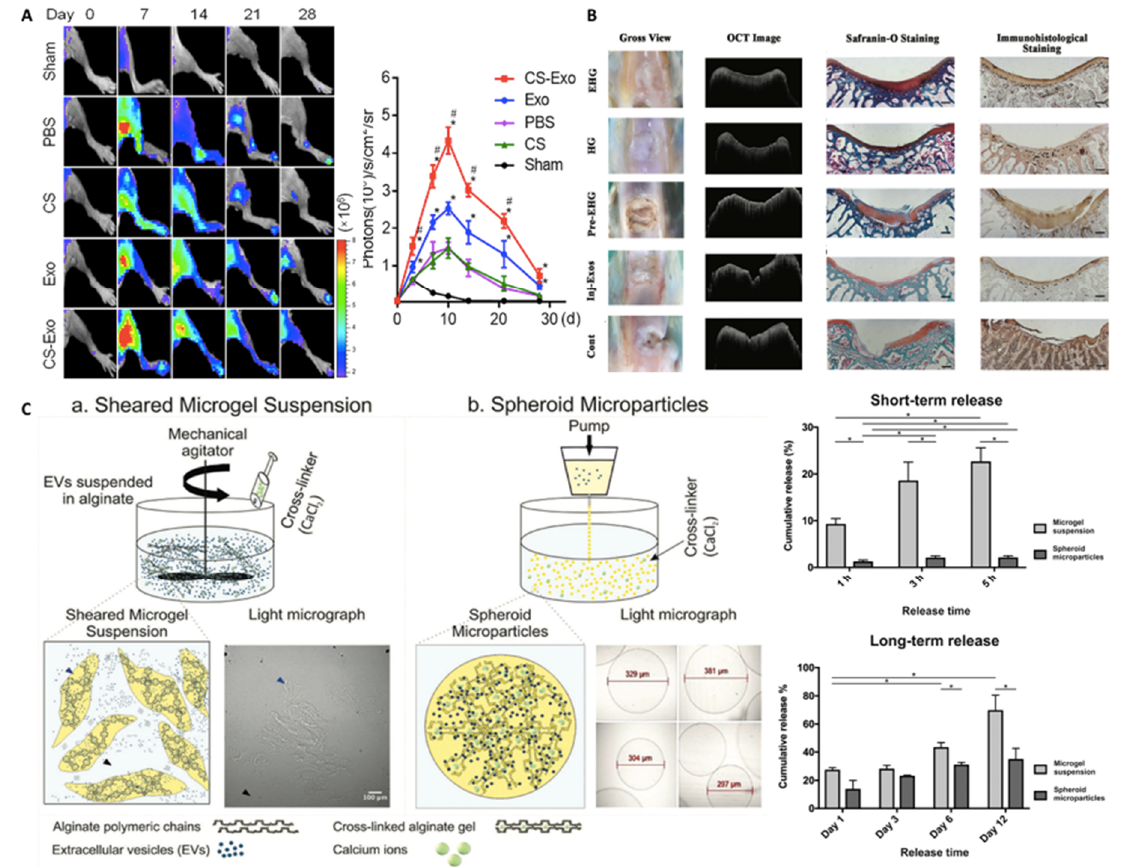
Figure 8. Encapsulation of EVs within different hydrogel systems. ( A ) MSC-derived exosomes with an injectable hydrogel for hindlimb ischemia treatment. EVs encapsulated within chitosan hydrogel demonstrated enhanced retention at the site of injury when compared to local delivery with EVs alone. Adapted from [134], with permission from American Chemical Society, 2018. *, p < 0.05 compared to PBS; #, p < 0.05 compared to Exo. ( B ) Superior reparation of articular full-thickness rabbit defects treated with in situ forming EV-functionalised hydrogel (EHG) when compared to hydrogel alone (HG), pre-formed EV-hydrogel (Pre-EHG), EV delivery alone (Inj-Exos). Adapted from [136], with permission from Royal Society of Chemistry, 2017. ( C ) Development of two technologies capable of controlling the release kinetics of encapsulated EVs. Reproduced from [137], with permission from John Wiley and Sons, 2019. *, p <